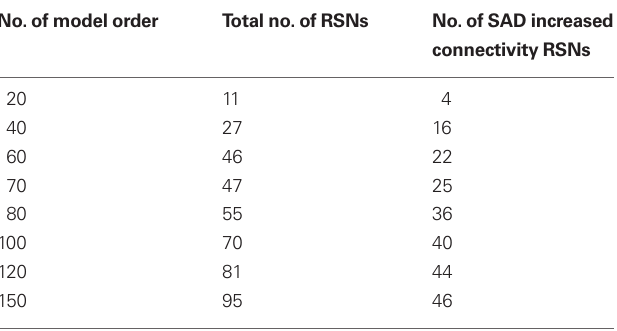
Table 2 | The table shows the total number of resting-state networks (RSNs) and RSNs with a significant abnormal connectivity.